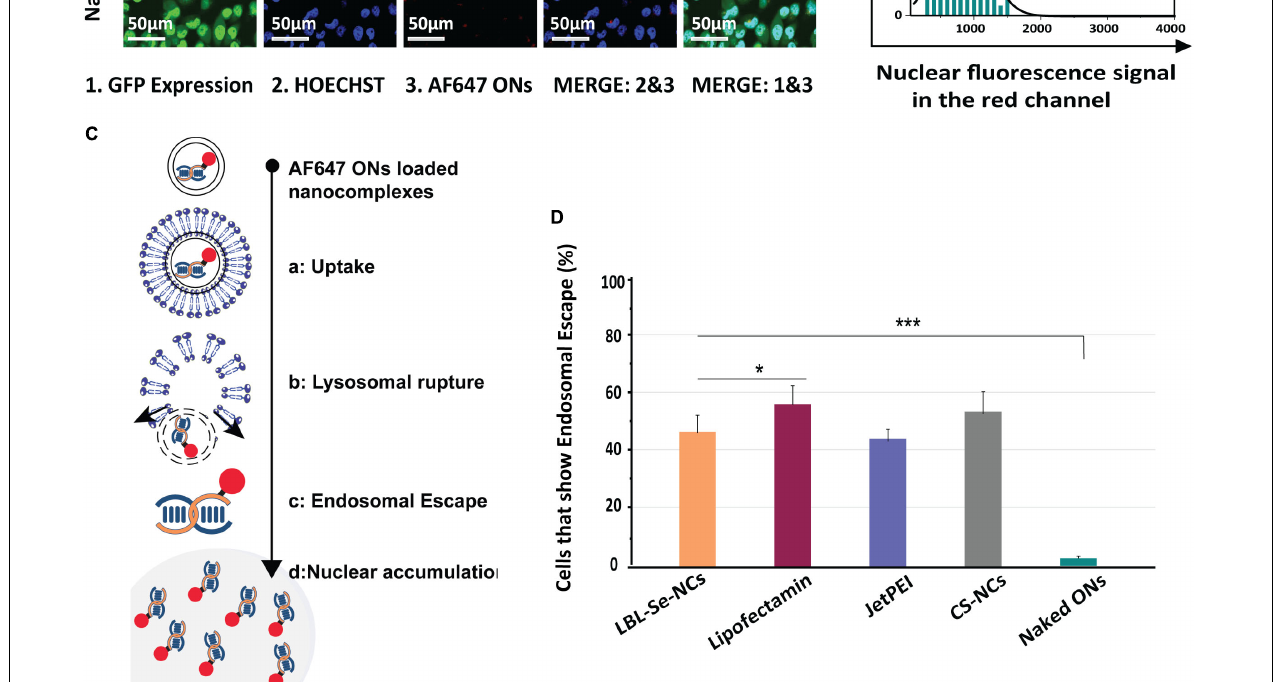
Frontiers in Molecular Biosciences |